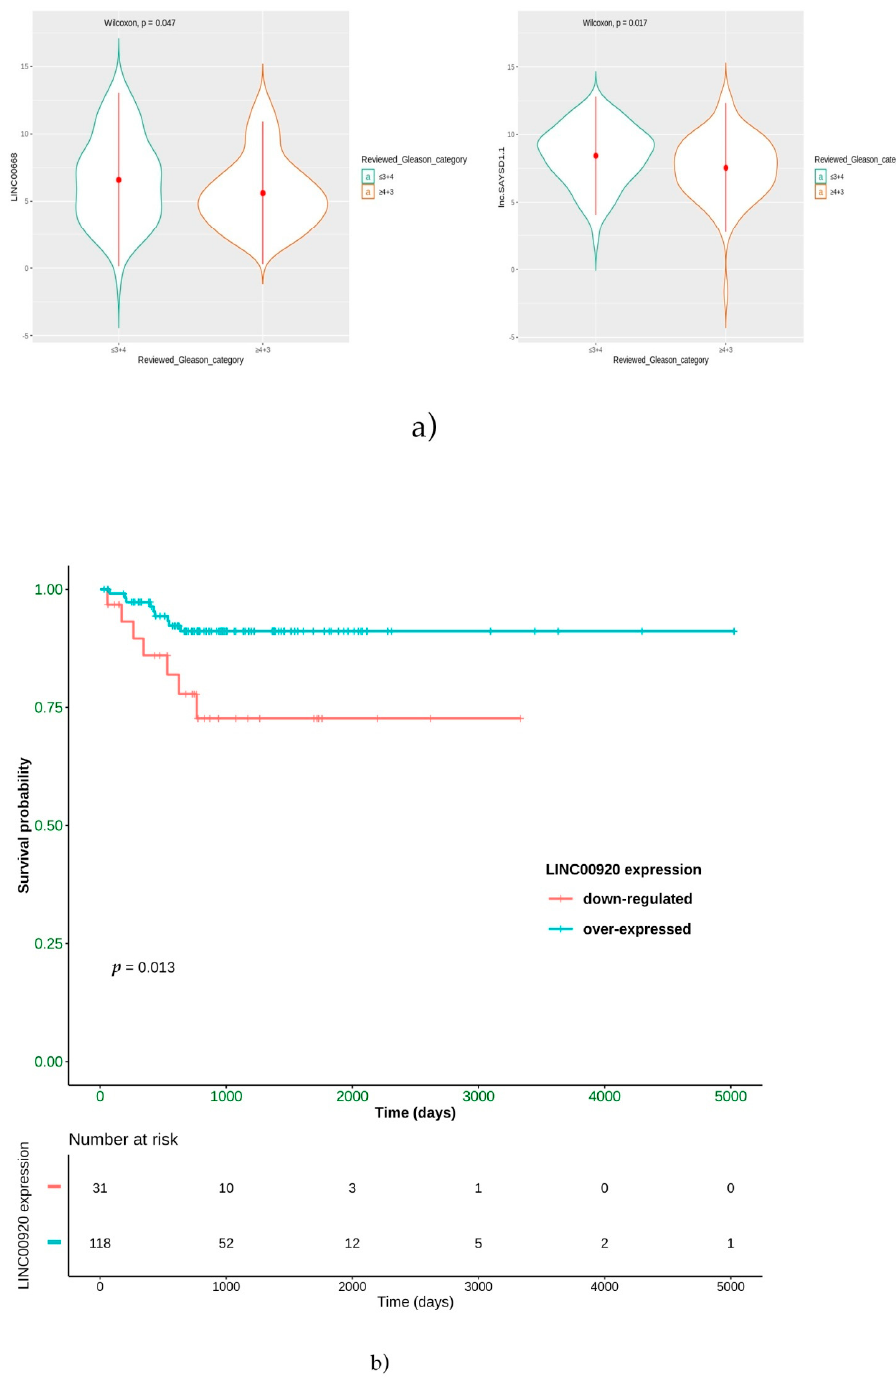
Figure 6. ( a ) Violin plots showing that ERG-positive patients with Gleason scores ≤ 3+4 overexpress LINC00668 and lnc-SAYSD1-1. ( b ) PFS Kaplan-Meier curve stratifying the ERG subset according to the LNC00920 expression.